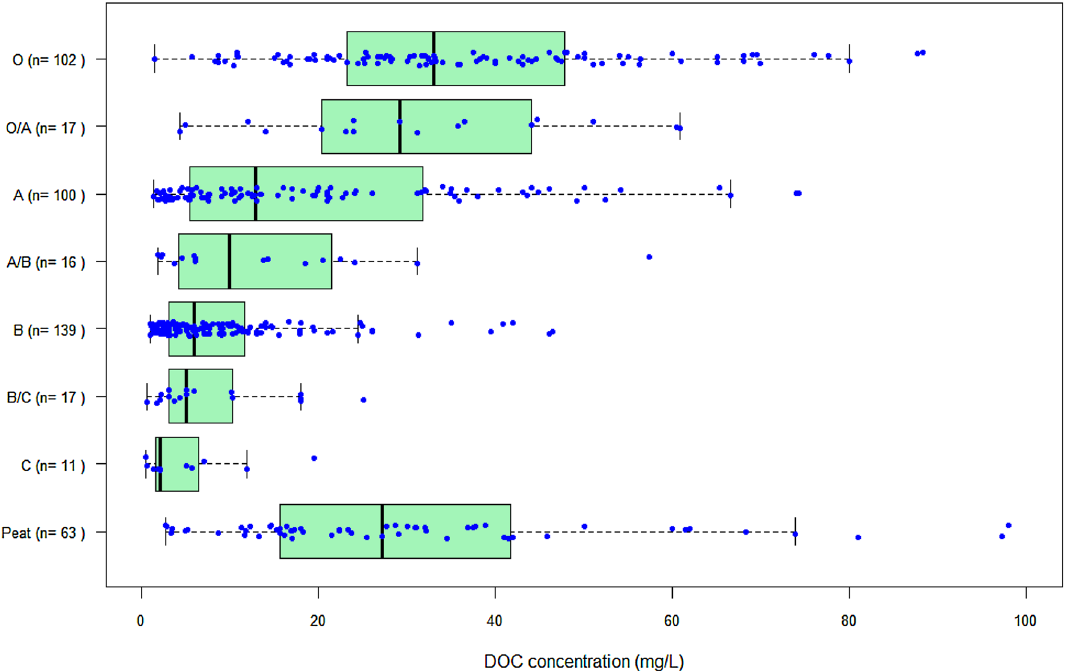
and upper quartile, unless exceeding the minimum or maximum. Individual data are jittered for visualization purposes. Five high non-lab-incubation values from peat samples (up to 372 mg C L −1 ) are outside the figure range, but included in the